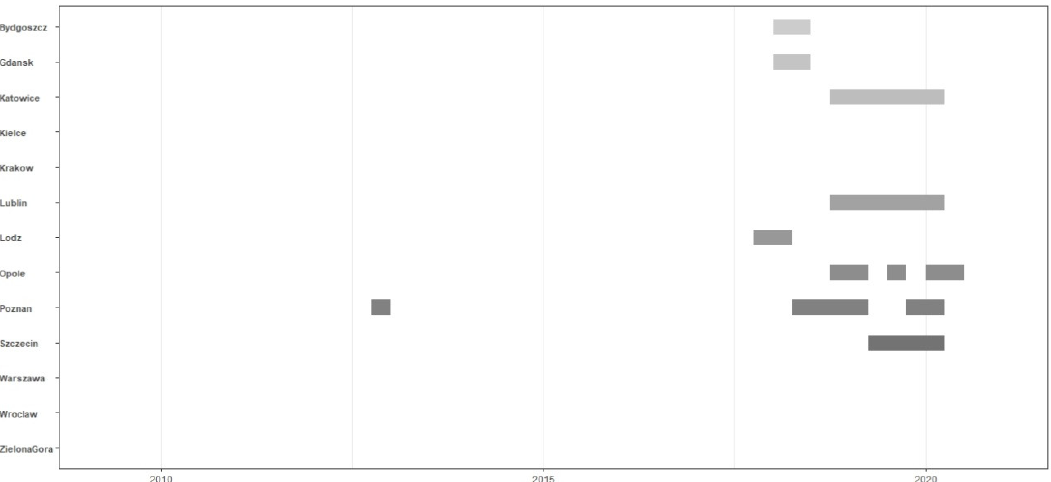
Figure 6. Date-stamping periods of exuberance in local housing markets.